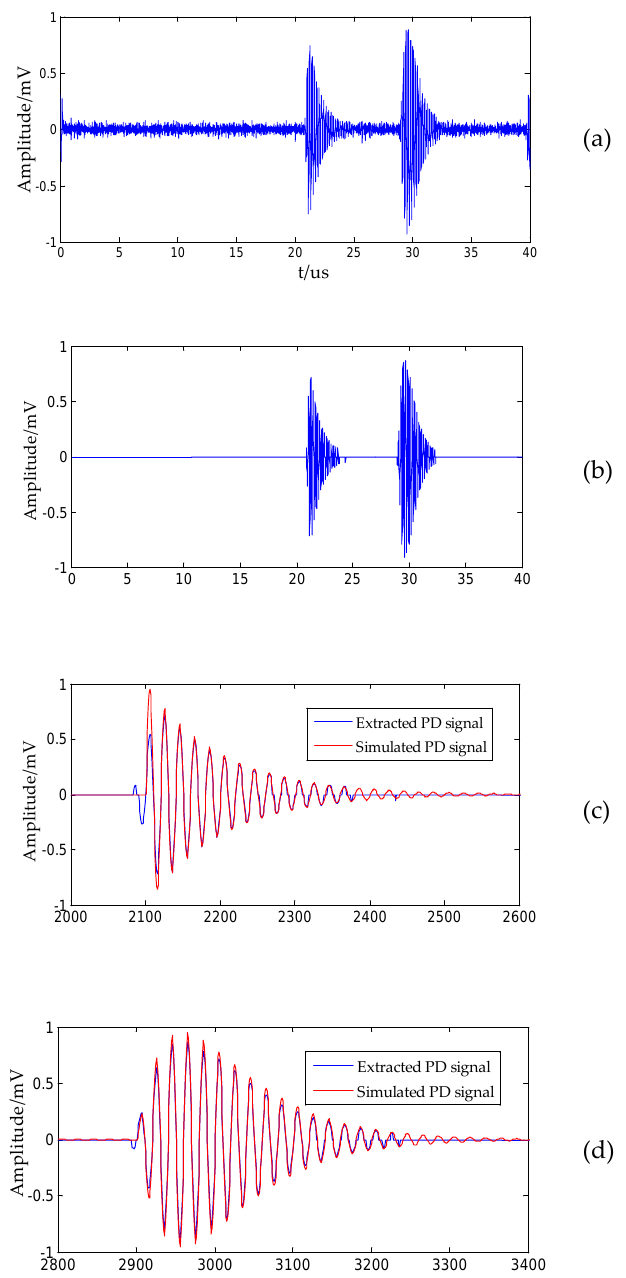
Figure 6. De-noising results of the proposed method. ( a ) Result of adaptive variational mode decomposition (VMD). ( b ) Further result of adaptive wavelet packet de-noising. ( c ) Comparison of de-noising and real PD signal of pulse 1. ( d ) Comparison of de-noising and real PD signal of pulse 2.